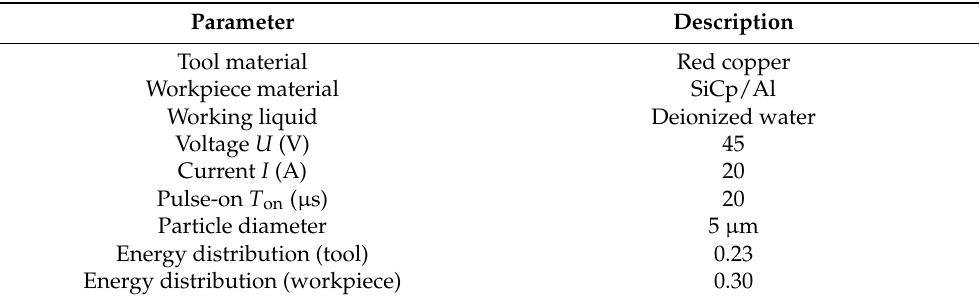
Figure 4. The meshed model. Figure 3. The boundary conditions in the melting simulation model. Table 1. Simulation parameters in the melting simulation.